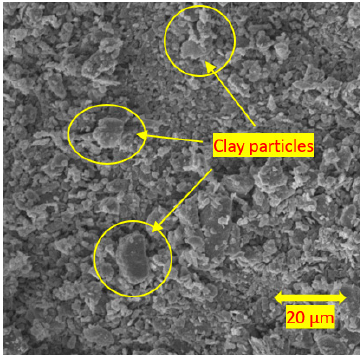
Figure 14. SEM image of clay at 20 μ m.